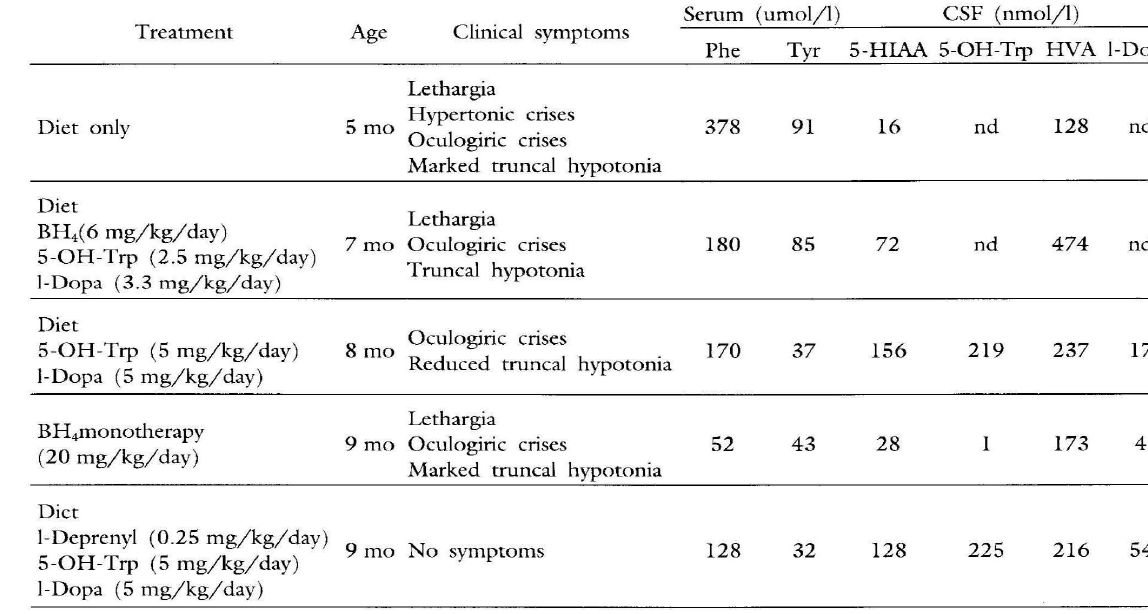
Table 1. Clinical and biochemical monitiring in a patient affected by dihydropteridine reductase deficiency during dif ferent